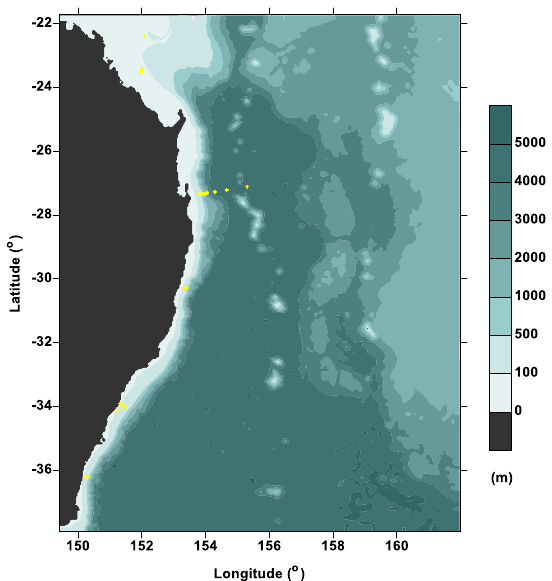
Fig. 1 Model domain with bathymetry with Integrated Marine Observing System (IMOS) moorings indicated as yellow